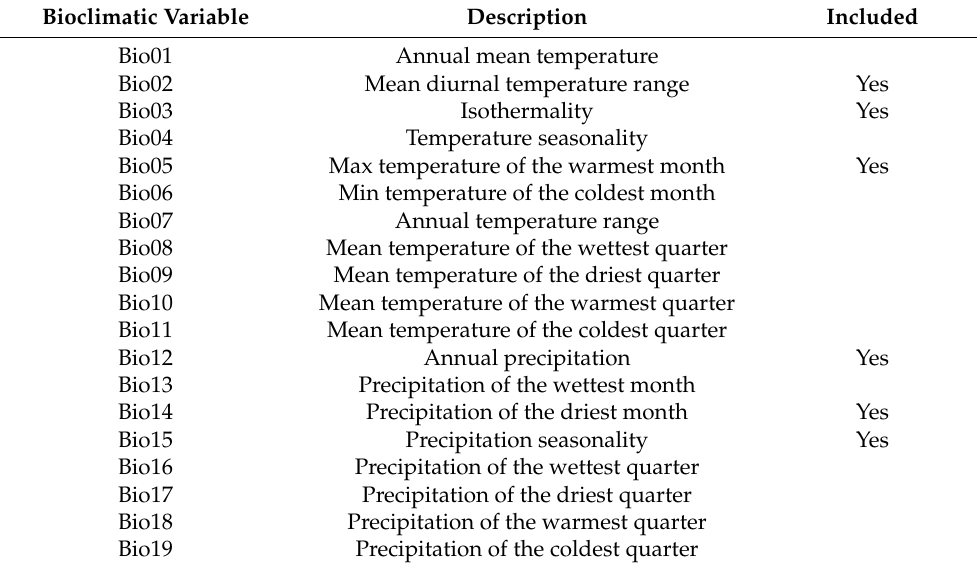
Table 1. Bioclimatic variables used in the model.